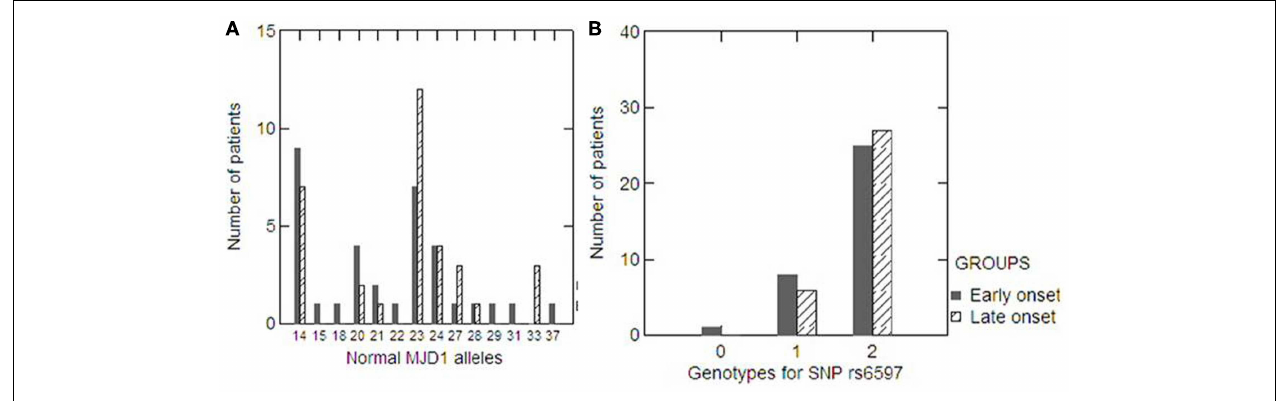
FIGURE 2 | Distribution of normal ATXN3 (CAG) repeat alleles in the extremely early (black column) and late (dashed column) onset groups (A). Distribution of genotypes for the SNP rs6597 within the CHIP gene in the extremely early (black column) and late (dashed column) onset groups (B)